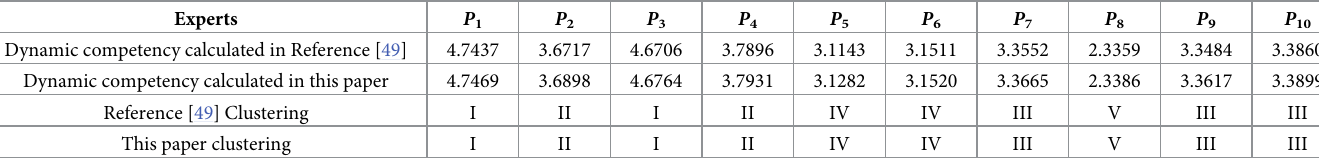
(cid:0) P 0 bid evaluation experts’ dynamic competency. 1 10